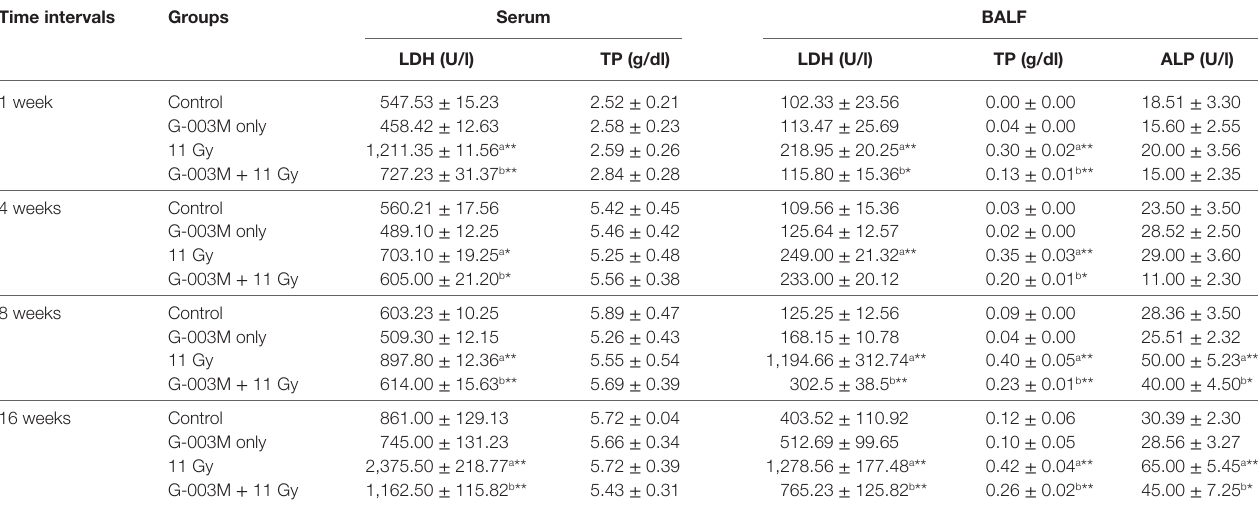
TaBle 1 | Level of lactate dehydrogenase (LDH), total protein (TP), and alkaline phosphatase (ALP) in serum/bronchoalveolar lavage fluid (BALF) of differentially treated C57BL/6 mice. Time intervals